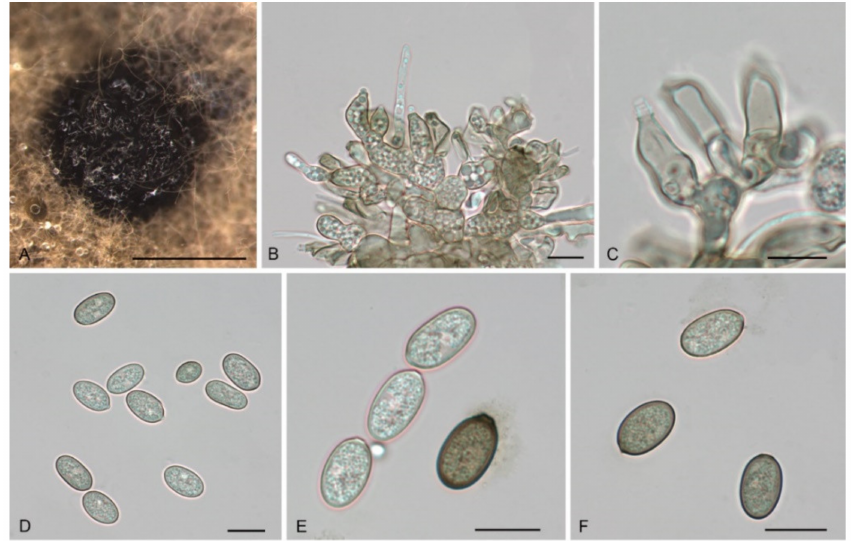
Figure 12. The morphology of Tubakia quercicola (CFCC 55106). ( A ) Conidiomata formed on PDA; ( B – C ) Conidiogenous cells giving rise to conidia; ( D – F ) Conidia. Scale bars: ( A ) = 100 µ m; ( B – F ) = 10 µ m. Mycobank no.: